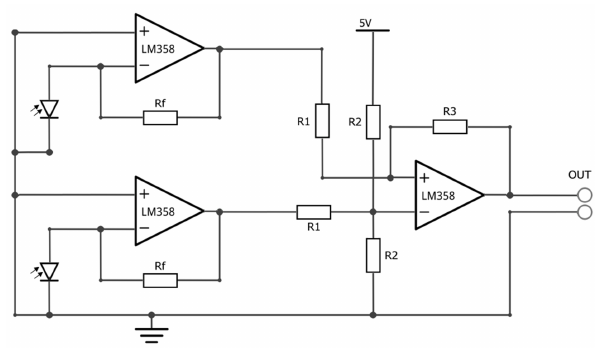
Figure 10. Circuit configuration for optical measurement: tran- simpedance